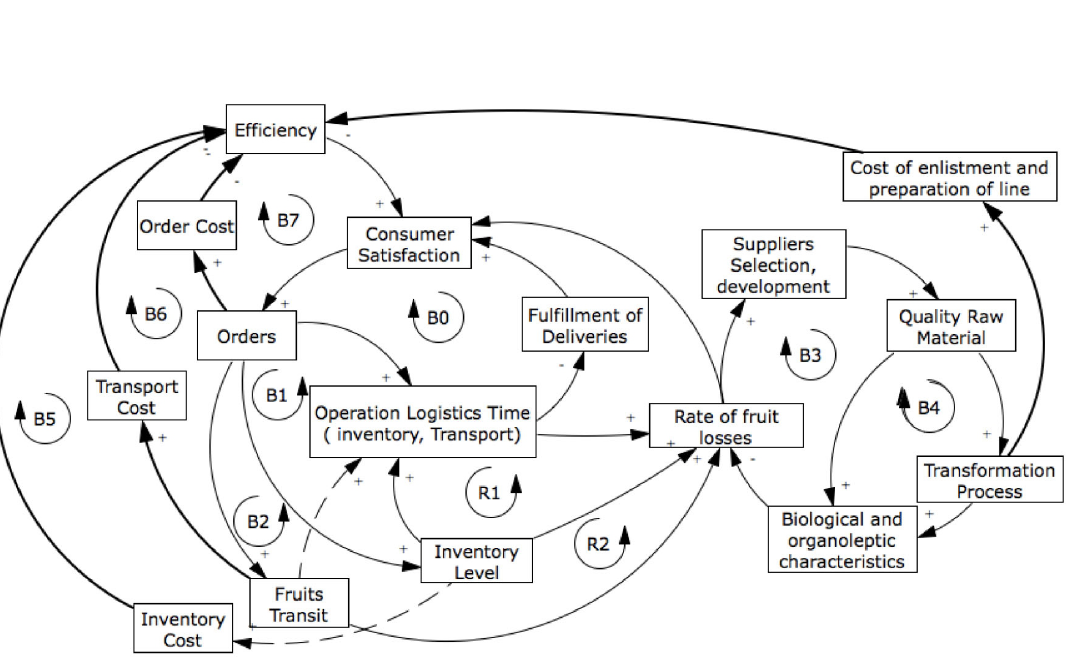
Figure 2. Causal diagram of the relationships between